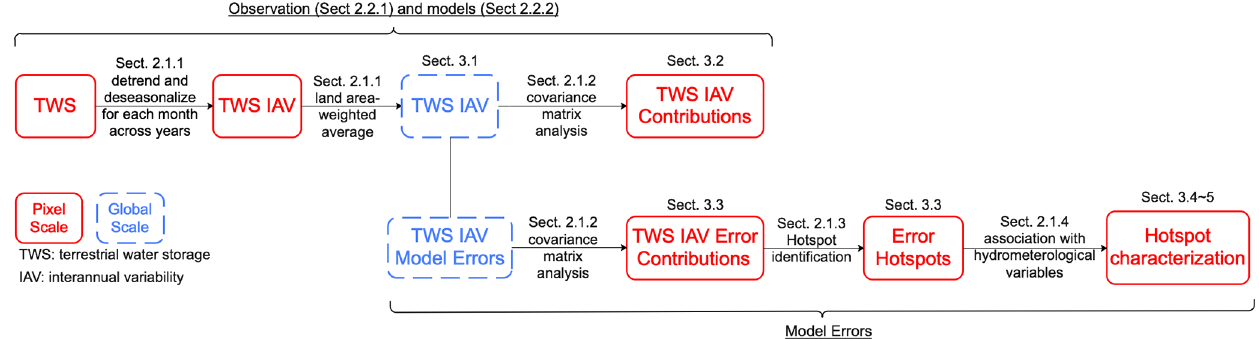
Figure 1. Schematic overview of the methodology to diagnose modeling errors in the simulation of the global TWS IAV. The sections of the paper that cover different aspects of the analysis are provided with section